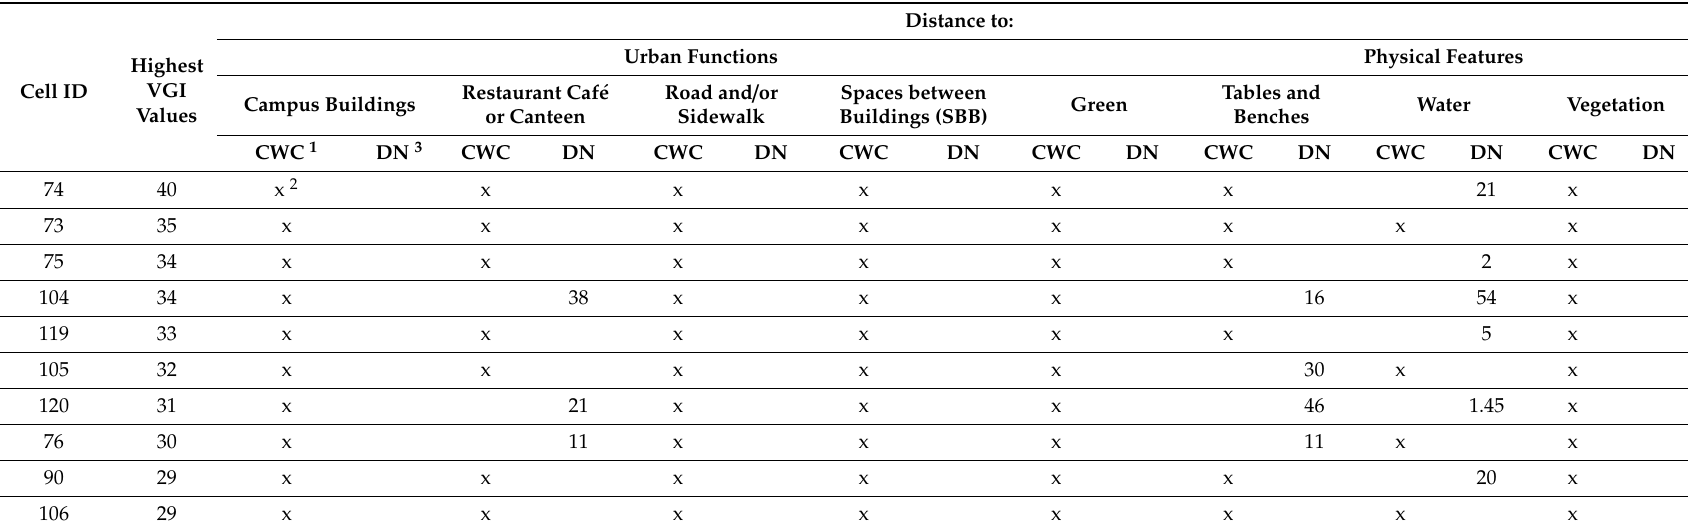
Table 9. Distances between VGI data and built-environment features